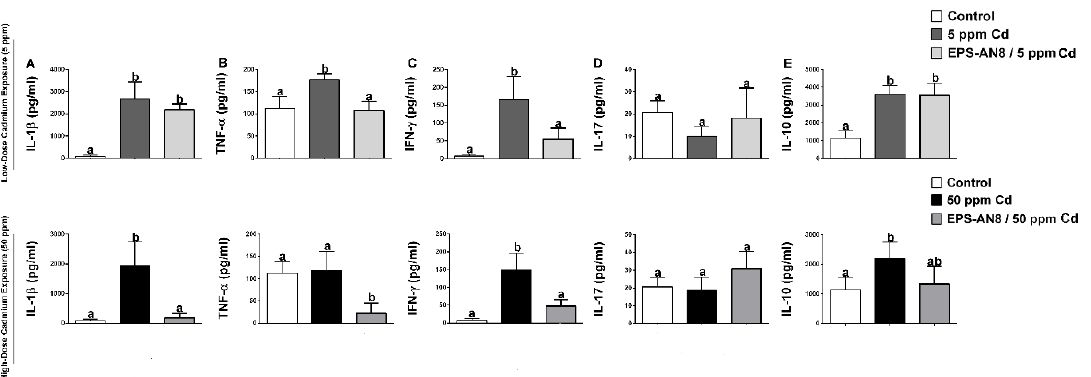
Figure 4. The ameliorating role of EPS-AN8 on Cd-induced cytokine production. It was measured production of ( A ) IL-1 β , ( B ) TNF- α , ( C ) IFN- γ , ( D ) IL-17, ( E ) IL-10 Results are presented as mean ± SD. Values that do not share a common letter are significantly different ( p <